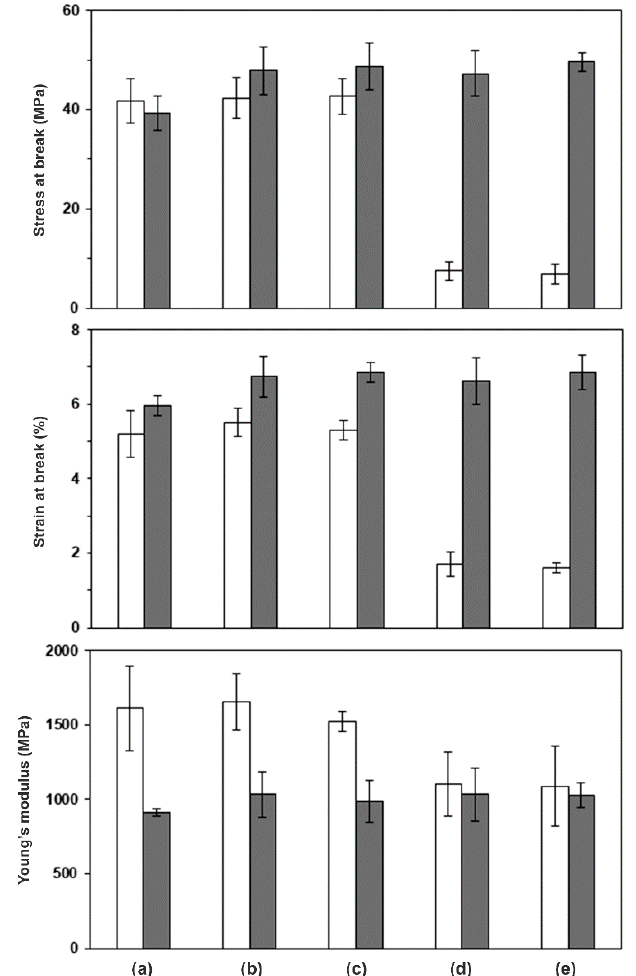
Figure 4. Tensile properties of ( (cid:3) ) non-chain-extended and ( (cid:4) ) chain-extended scPLA films with PLLA/PDLA ratios of (a) 100/0, (b) 90/10, (c) 80/20, (d) 70/30 and (e) 60/40 ( w / w ).